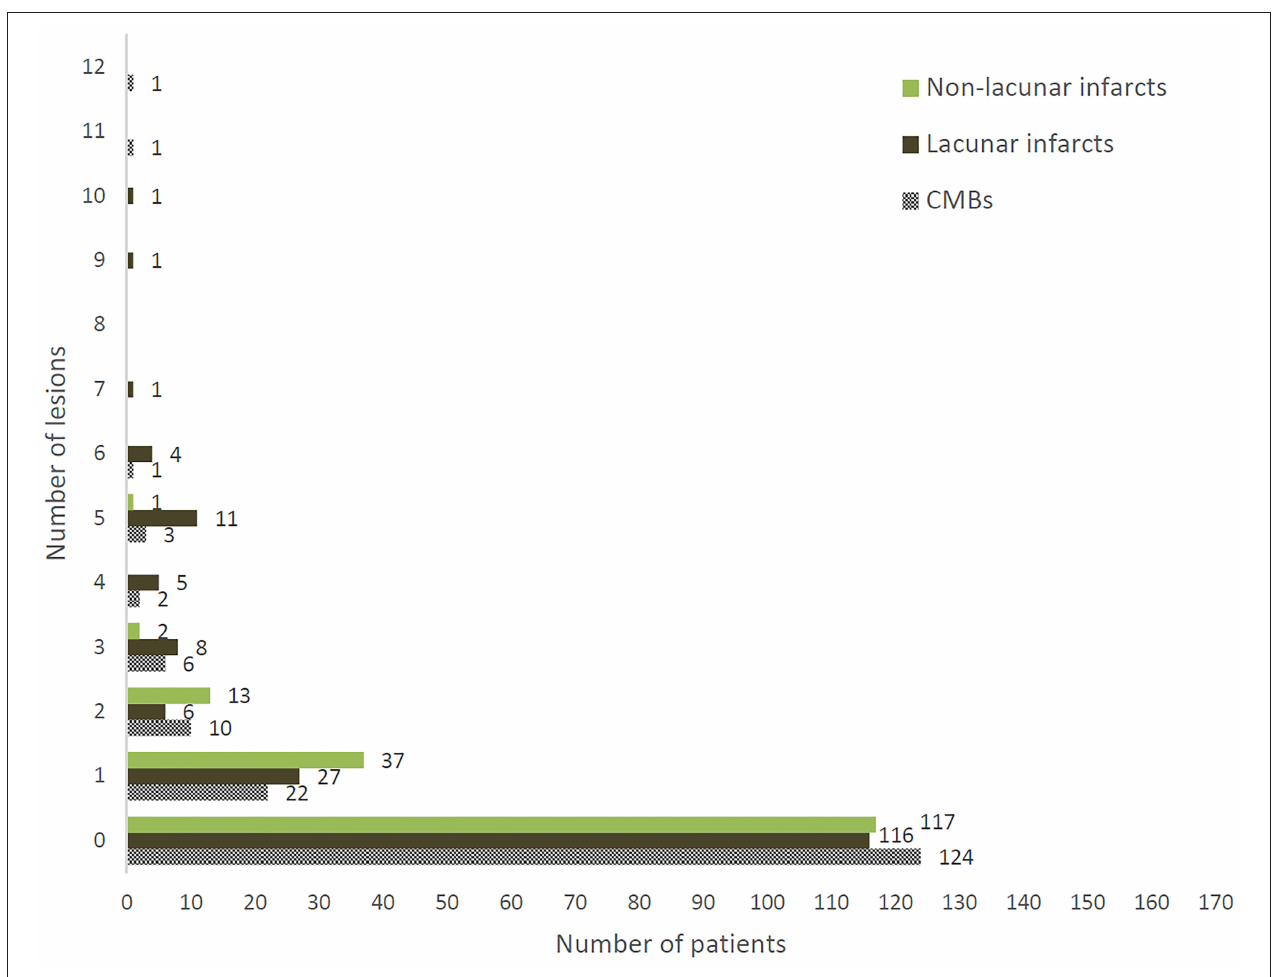
FIGURE 1 | Distribution of number of CMBs, lacunar infarcts, and non-lacunar infarcts in 170 patients enrolled in Strat-AF